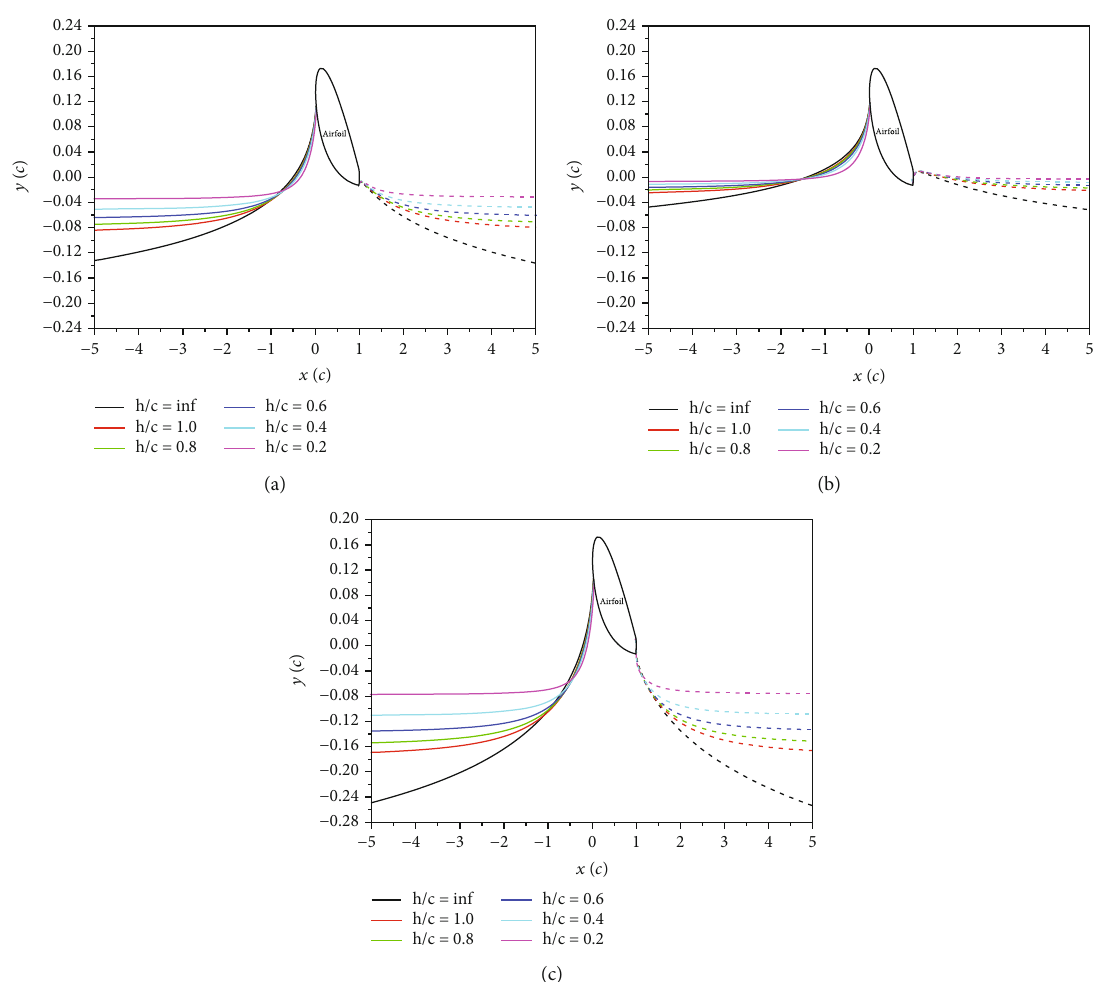
Figure 33: Two key streamlines for various ride heights at α = 8 ° : (a) without blowing; (b) with C